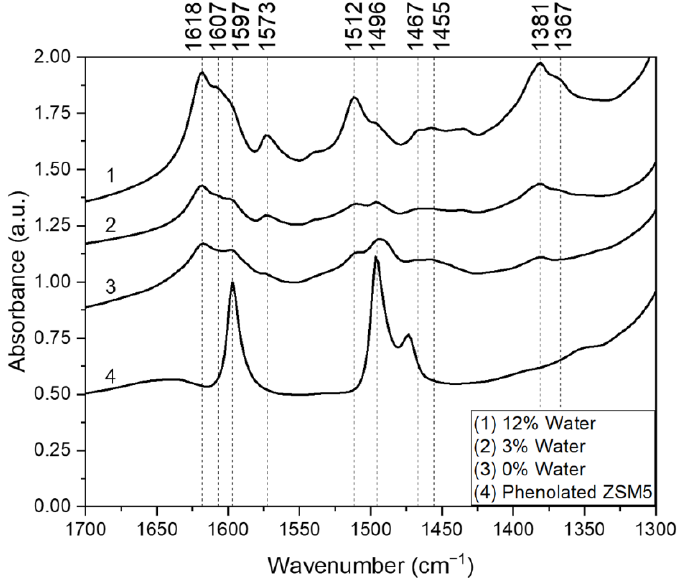
Figure 8. Infrared spectra in the aromatic region of post reaction ZSM-5 (1 – 3) and phenolated ZSM-5 (4).